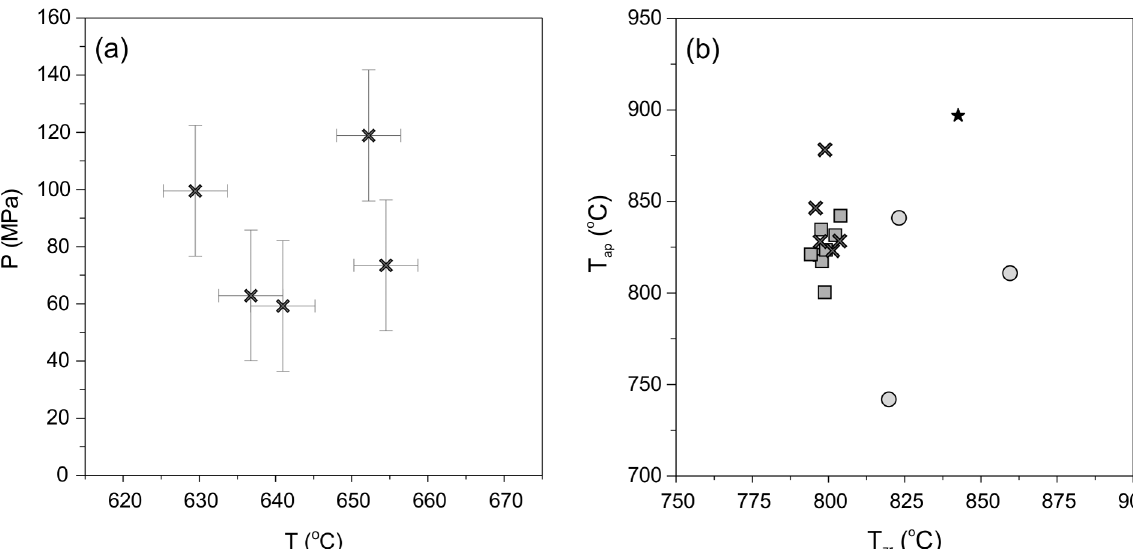
Figure 17 - Thermobarometric estimates for the Quiriri Pluton, Morro Redondo Complex. (a) Plagioclase-hornblende thermometry estimates (T in °C) of Holland and Blundy (1994) vs. Al-in-hornblende barometric estimates (P in MPa) of Anderson and Smith (1995). Uncertainty lines in T and P in each estimative represents 1σ precision error. (b) Zirconium-Saturation Thermometry estimates (T °C) of Watson and Harrison (1983) vs. Apatite Saturation Thermometry estimates (T Zr Symbols as in Fig